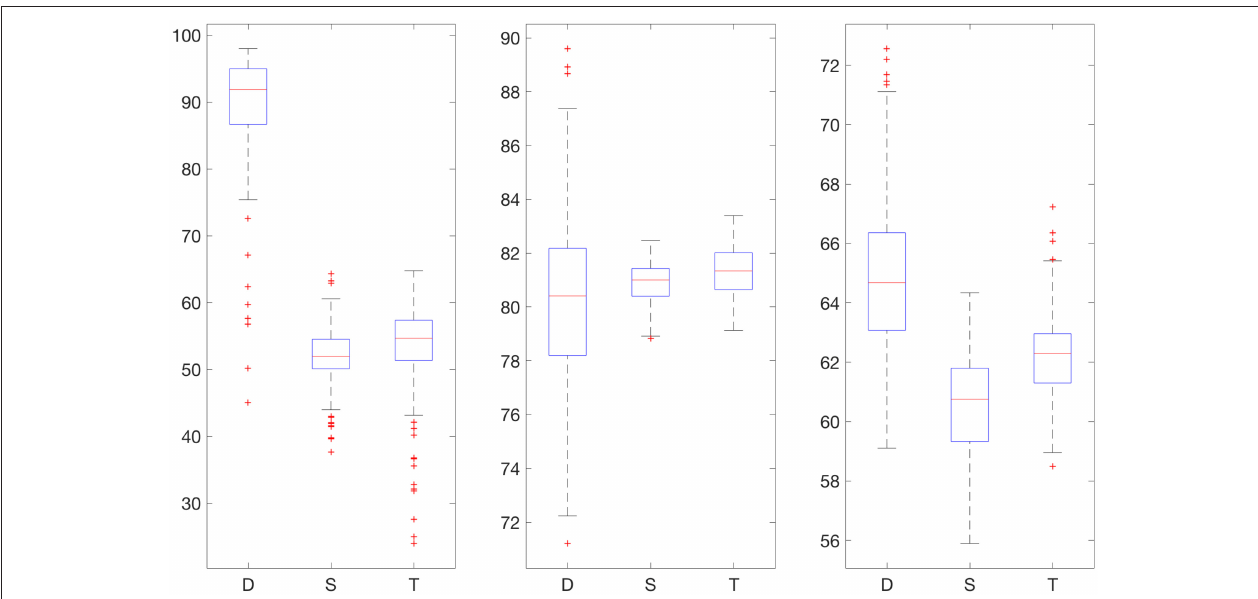
FIGURE 3 | Boxplot for the 100 experiments conducted with no smoothing and 50% training data for each prediction method (D, deep network; S, shallow network; T, Tikhonov regularization). The three graphs show the percentage accurate predictions in the hypoglycemic range (left), euglycemic range (middle) and hyperglycemic range (right).